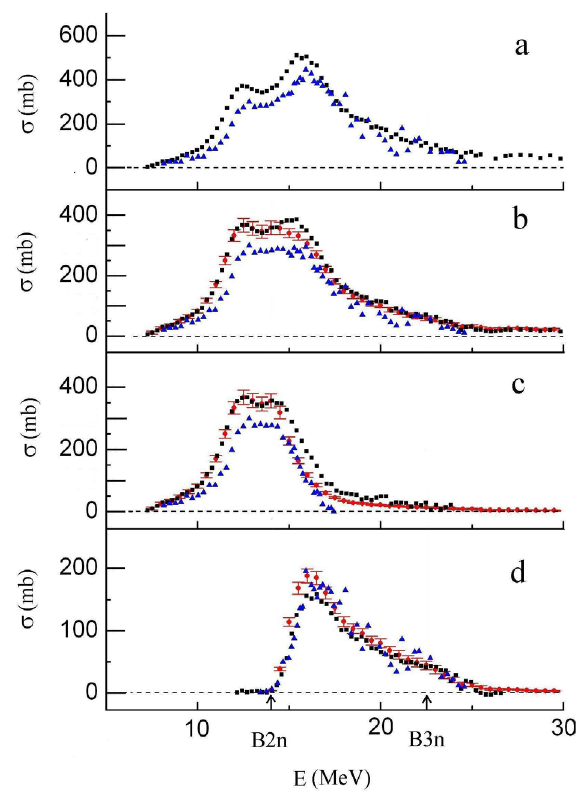
Figure 2. Evaluated ([10], circles) and experimental (Livermore [21], triangles and Saclay [22], squares) cross sections for 181 Ta: